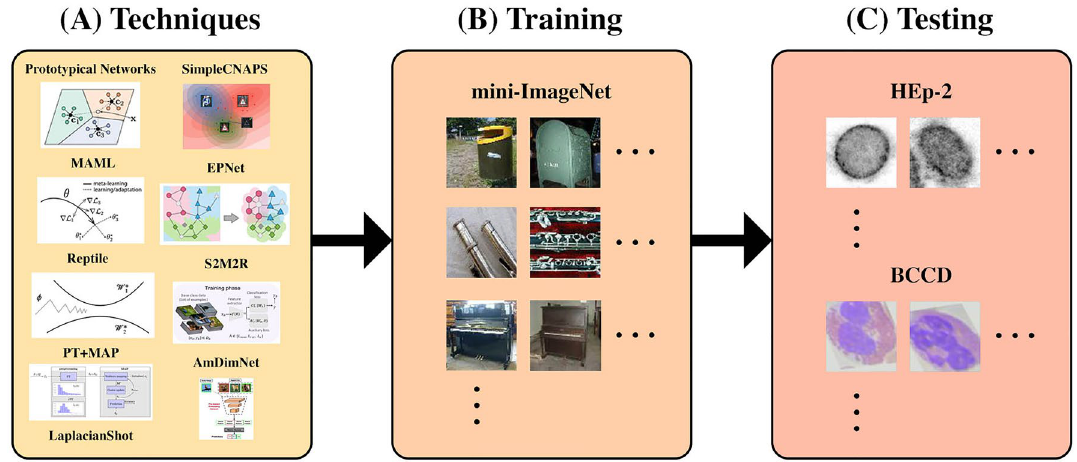
Figure 1. The process proposed for training and testing the nine selected few-shot learning techniques on out- of-domain data.